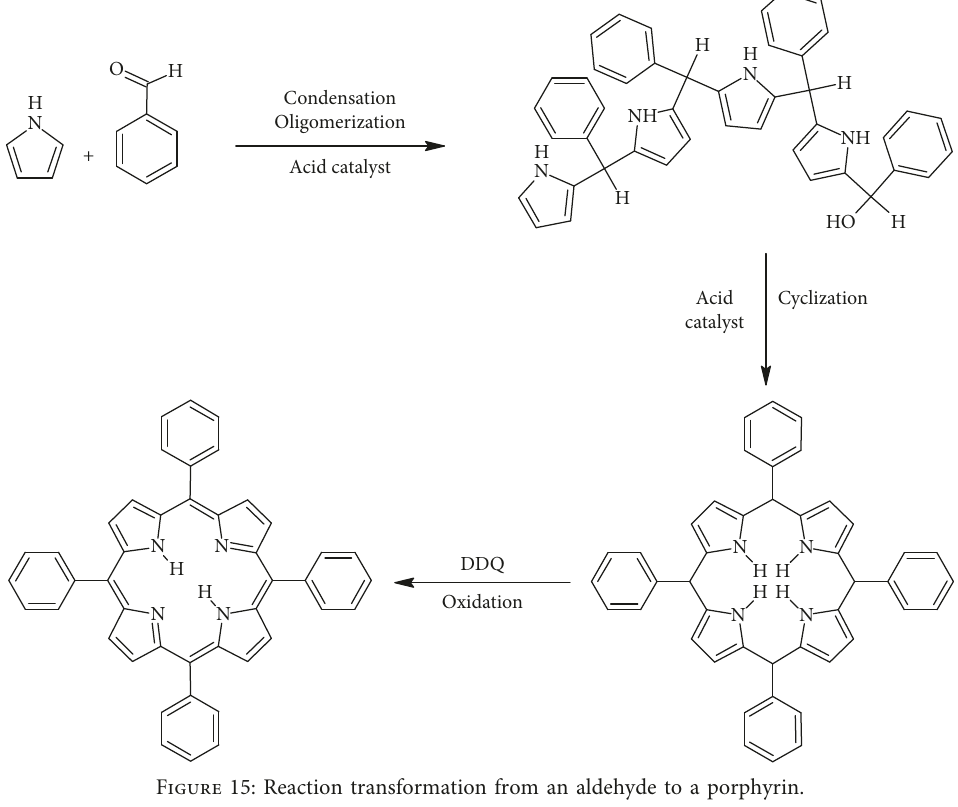
Figure 15: Reaction transformation from an aldehyde to a porphyrin.